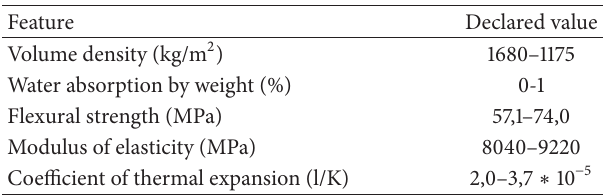
Table 1: Basic physicomechanical parameters of the acrylic-mineral (PMMA/ATH)